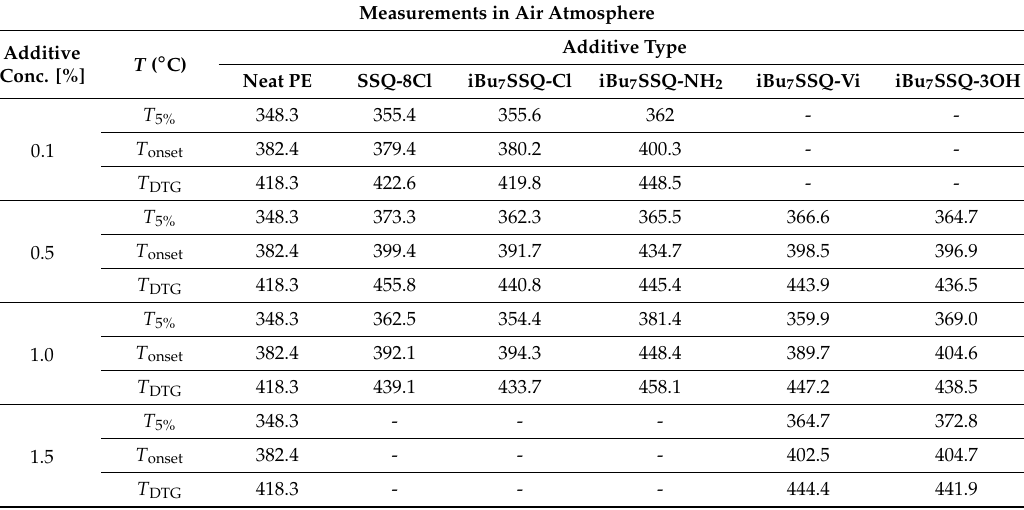
Table 4. Thermal parameters of SSQ / PE composites from TGA